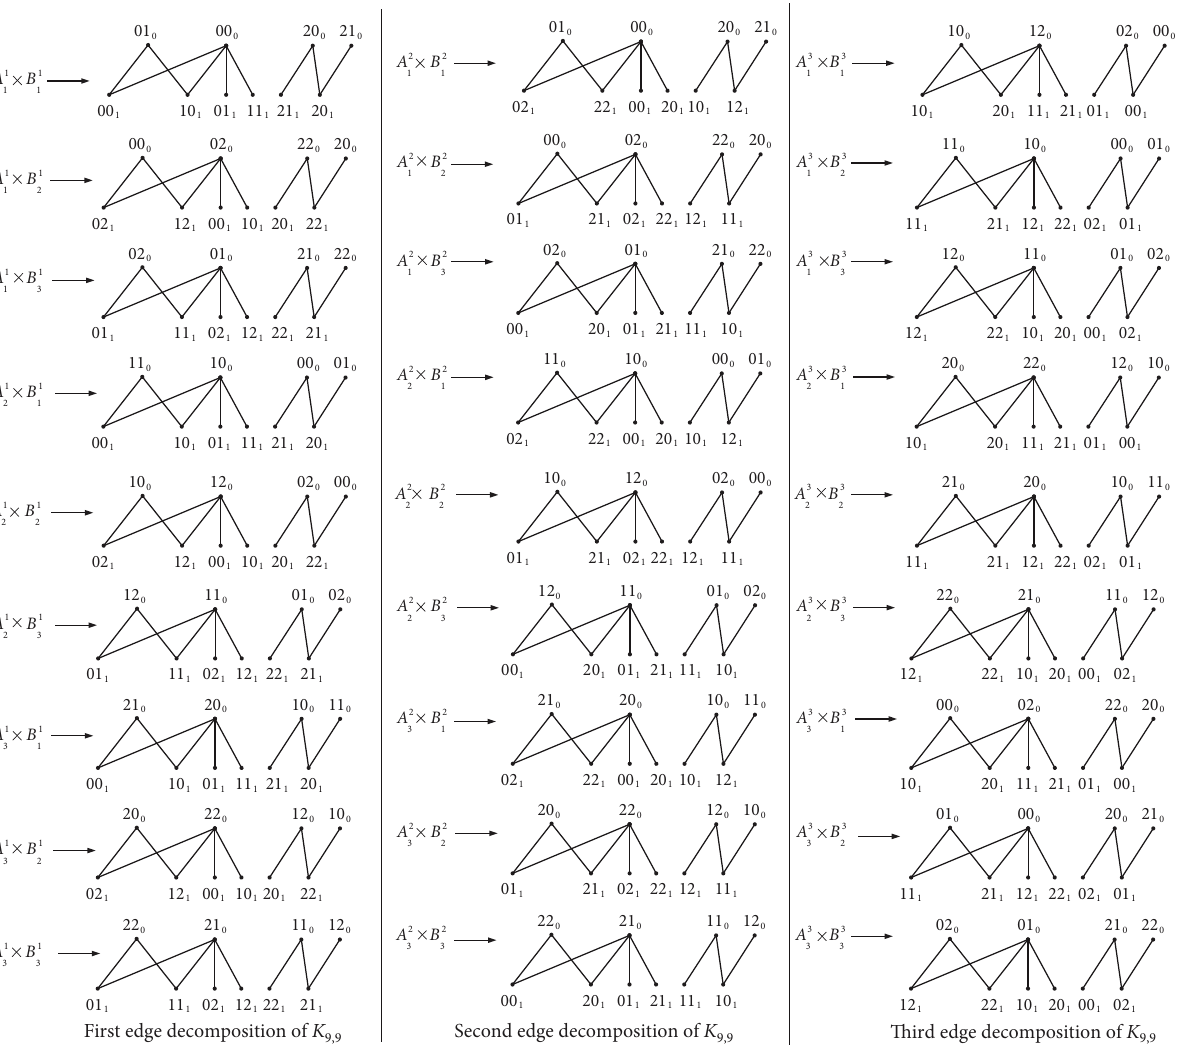
Figure 9: 3 mutually orthogonal covers of K